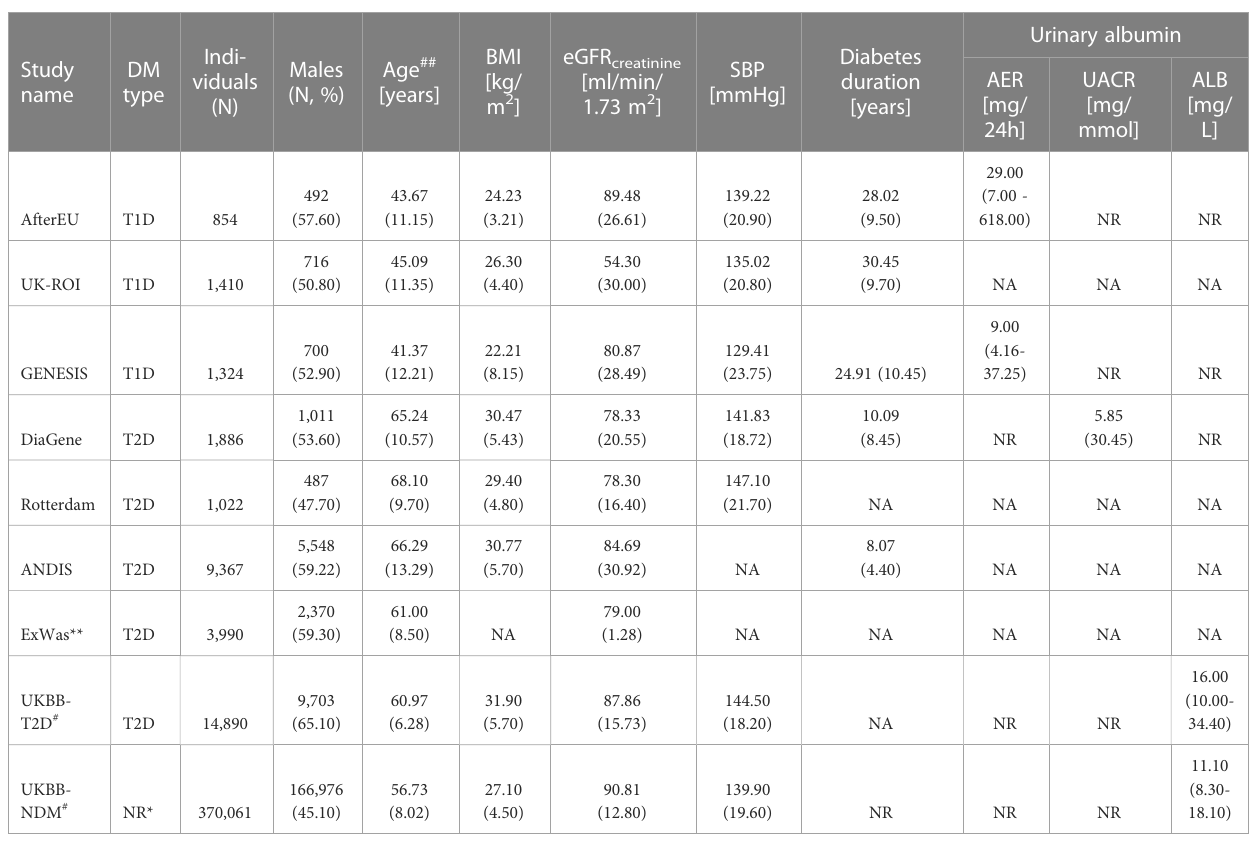
TABLE 1 Clinical characteristics of participating